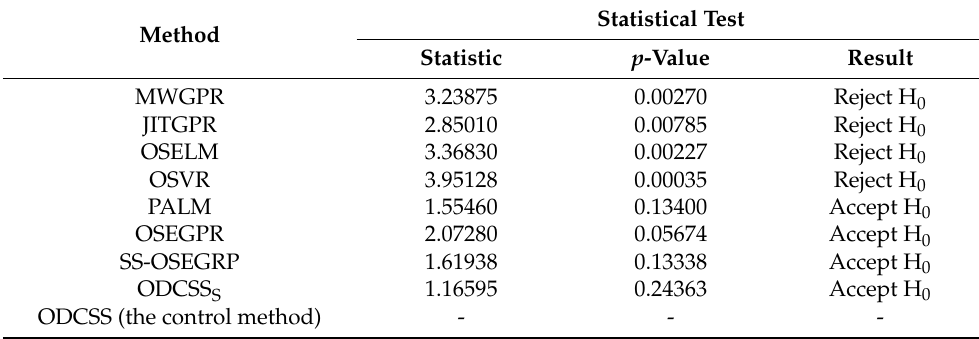
Table 9. Statistical test results for the RMSE differences on the testing subsets between ODCSS and other compared soft sensor methods in CTC fermentation